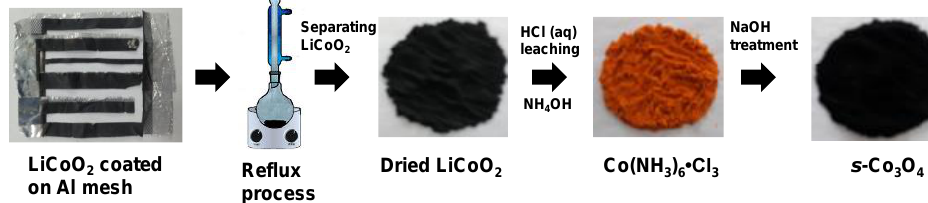
Figure 1. Scheme of the synthesis strategy for s -Co 3 O 4 NPs.